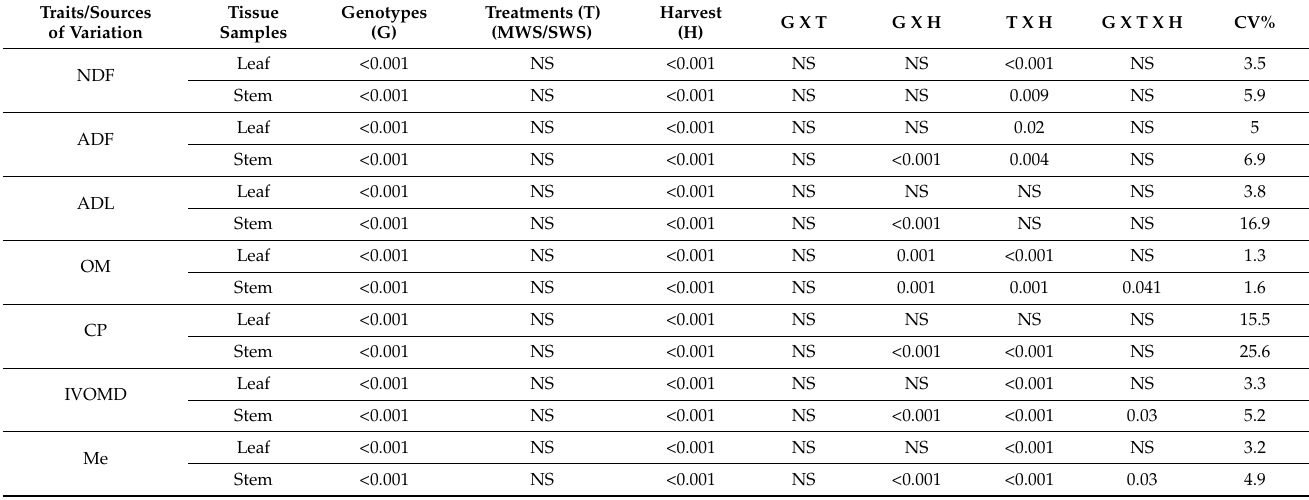
Table A7. ANOVA summary for seven feed quality traits of Napier grass genotypes for leaf and stem tissue in the wet season.